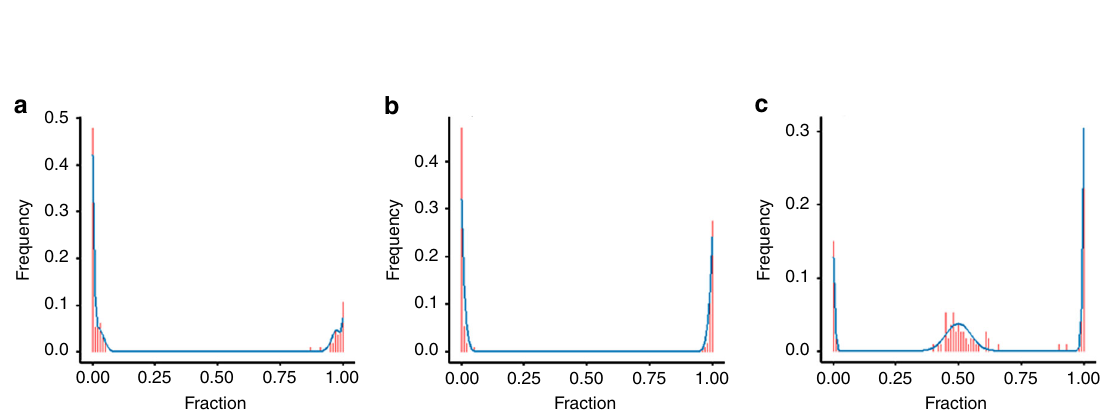
Fig. 1 Mixture distributions of (non-)imprinted SNPs. Observed (red) and modelled (blue) fraction of alternative alleles for two signi fi cantly imprinted SNP positions, i.e. a IGF2 (rs2585, adj. p -value < detection limit (LRT), î = 0.97) b SNRPN (rs705, adj. p -value = 1.81E-71 (LRT), î = 0.99), and a non-imprinted SNP, i.e. c CHMP6 (rs1128687, î = 0)